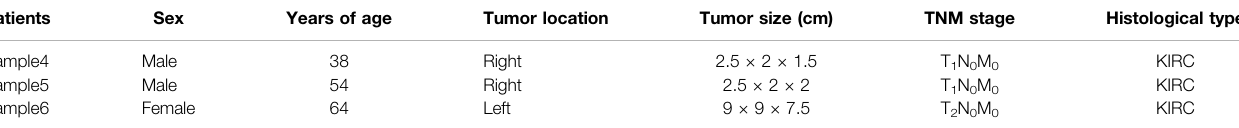
TABLE 5 | The characteristics of patients for FC.